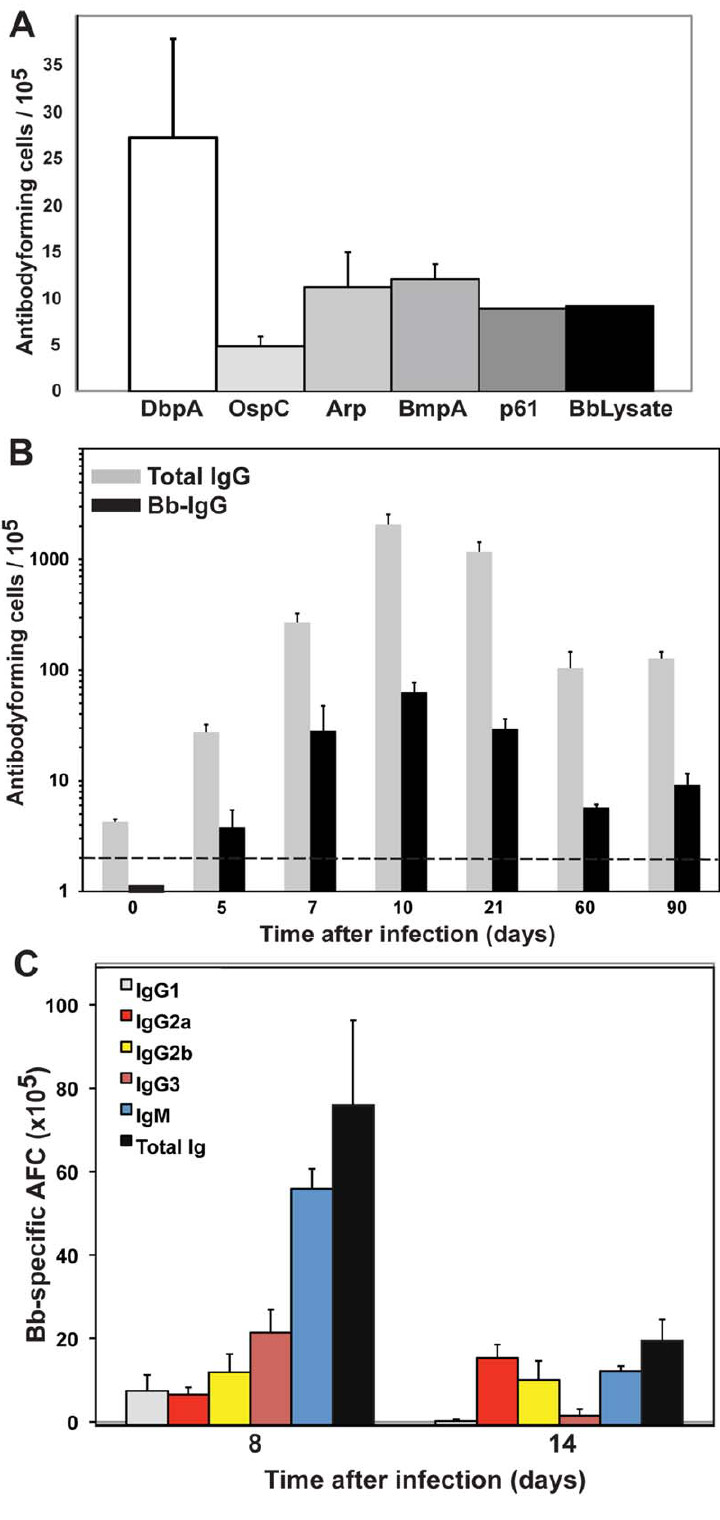
Figure 5. Strong induction of B.burgdorferi -specific antibodies following infection. ( A ) Indicated recombinant B. burgdorferi antigens and lysate were tested as coating reagents for ELISPOT to enumerate B. burgdoferi -specific antibody-secreting cells (AFC) in the inguinal lymph nodes of C57BL/6 mice infected for 14 days with host-adapted B. burgdorferi . Shown are mean numbers of antibody-secreting cells (AFC) 6 SD from 5 mice. ( B ) A pool of recombinant proteins (DbpA, OspC, Arp and BmpA) was used to determine the frequencies of B. burgdorferi -specific antibody-secreting cells (black bars) by ELISPOT in C57BL/6 mice at indicated times after infection. Grey bars indicate the total number of IgG-AFC per lymph node. For